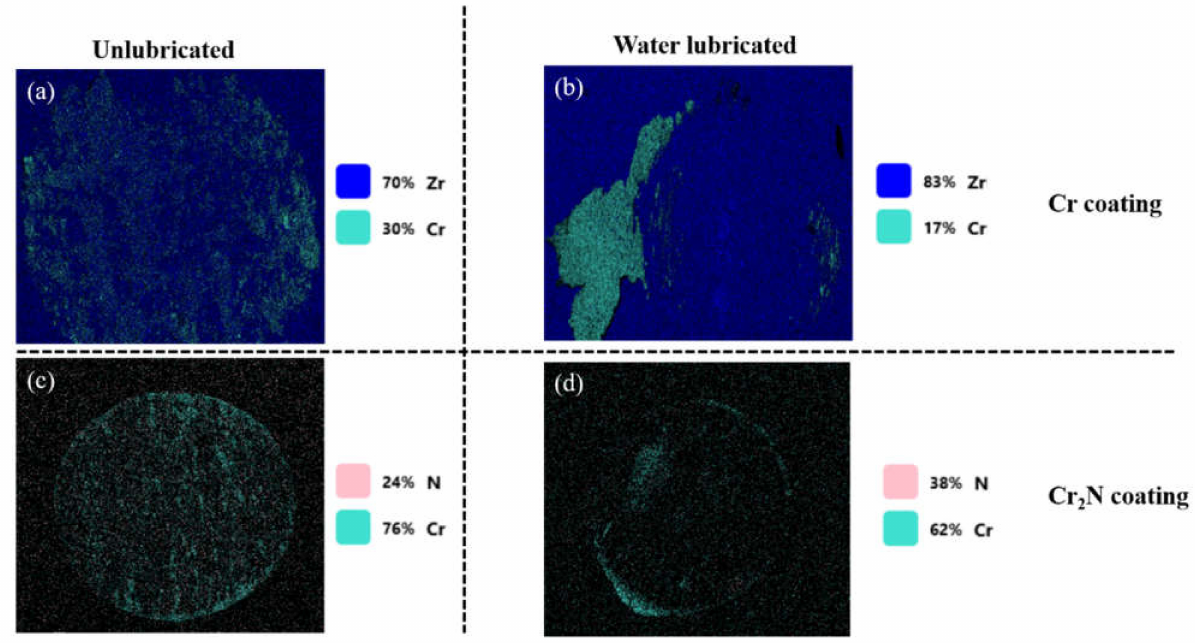
Figure 10. EDS maps of the wear area of the friction pairs of ( a , b ) Cr and ( c , d ) Cr 2 N coatings under unlubricated and water-lubricated